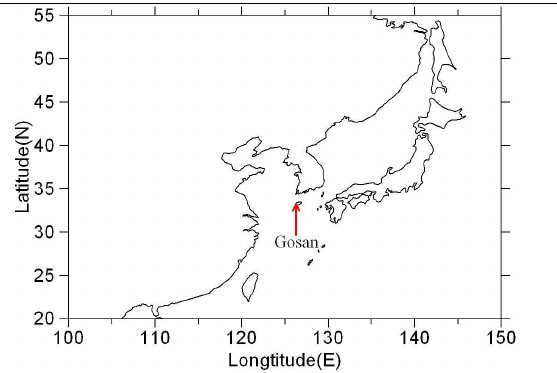
Figure 2. Gosan is located at the western tip of Jeju Island, Korea. Gosan ABC super site is located at 33.28ºN & 126.17ºE.